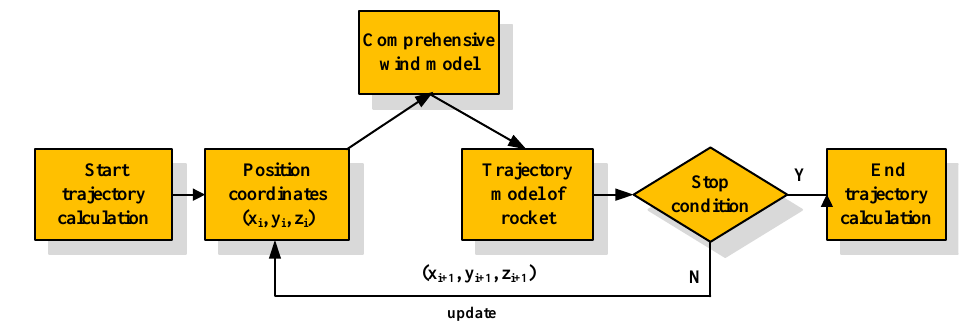
Figure 11. Flight simulation process.